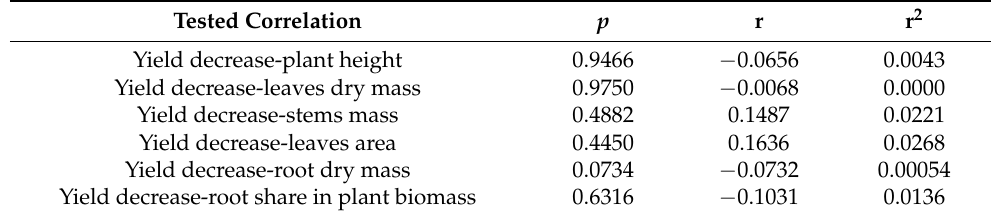
Table 4. Correlation coefficients between the selected morphological parameters of potato plant and yield decrease in relation to the control under heat